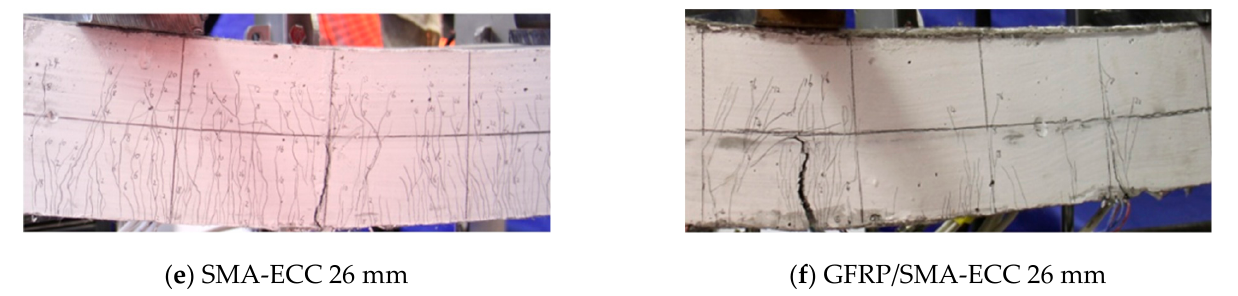
Figure 9. Failure modes and the crack widths of tested beams.